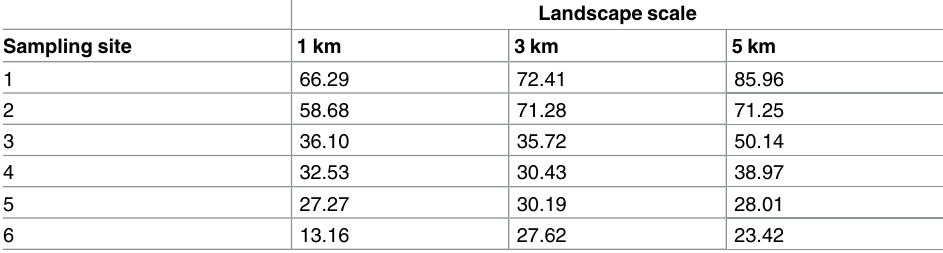
Table 1. Percent of forest vegetation cover for the six sampling sites in the Huastecaregion, in the state of Hidalgo, Mexico. For each site, vegetationcover was measuredin three spatialscales (buffers with different radius